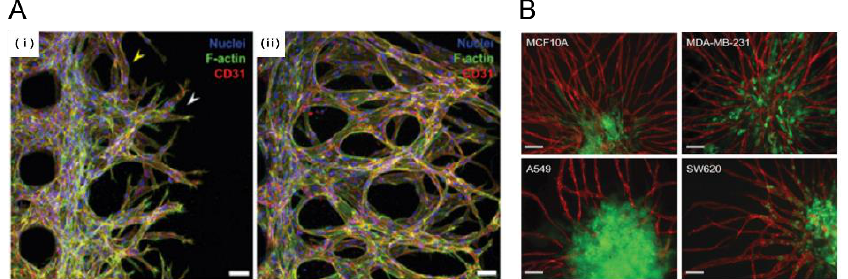
Figure 3. Tumor angiogenesis on a chip. ( A ) Human glioblastoma multiforme cells, (U87MG) were used to induce angiogenic sprouting. Fluorescence image shows angiogenic sprouts grown for 2 and 4 days under co-culture with U87MG cancer cells and human umbilical vein endothelial cells (HUVEC) (i, ii) [32]. Scale bar: 50 μm; ( B ) Pre-vascularized tumor (PVT) spheroid model. PVT spheroid model were introduced breast cancer (MCF10A, MDA-MB-231), Lung cancer (A549) and colon cancer (SW620). Representative fluorescence images of PVT spheroid model shows robust angiogenic sprouting. Various PVT spheroid showed different angiogneic sprouting behavior. Intravasation events were only observed for SW620 cancer cells [37]. Scale bar: 100 μm. Reproduced with permission.